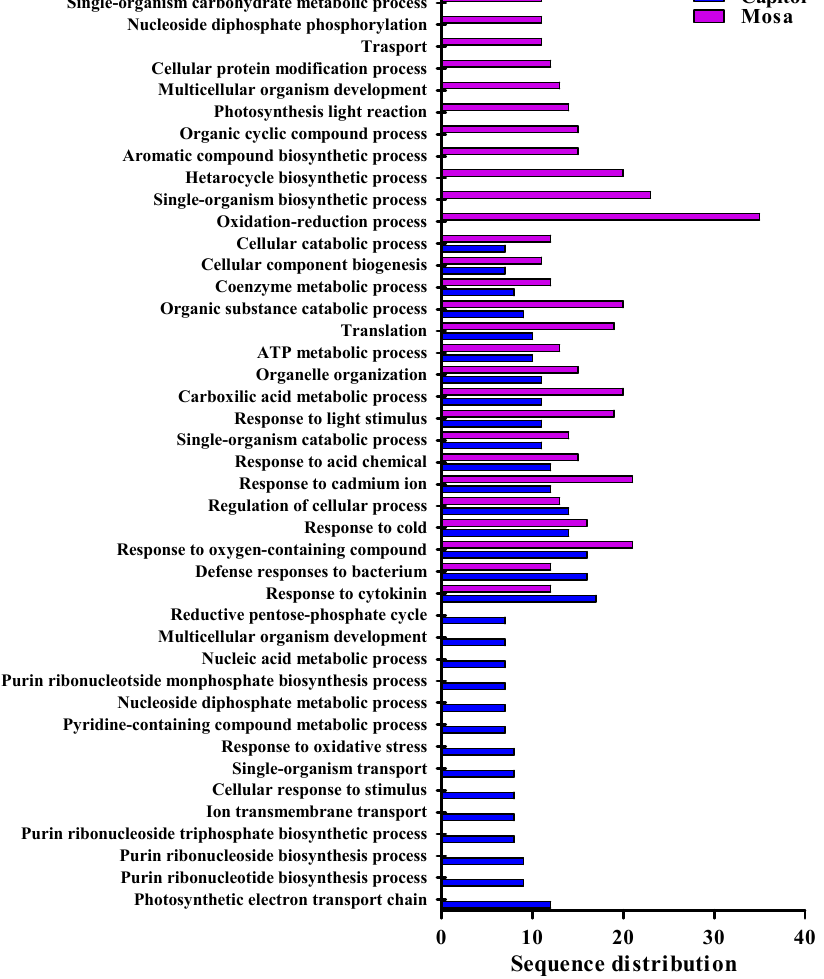
Figure 2. Functional classification of B. napus resistant cultivar (cv. Capitol) and susceptible cultivar (cv. Mosa) proteins in responses to Xanthomonas campestris pv. campestris ( Xcc ). Proteins were classified by gene ontology analysis with BLAST2GO on the basis of their biological processes.